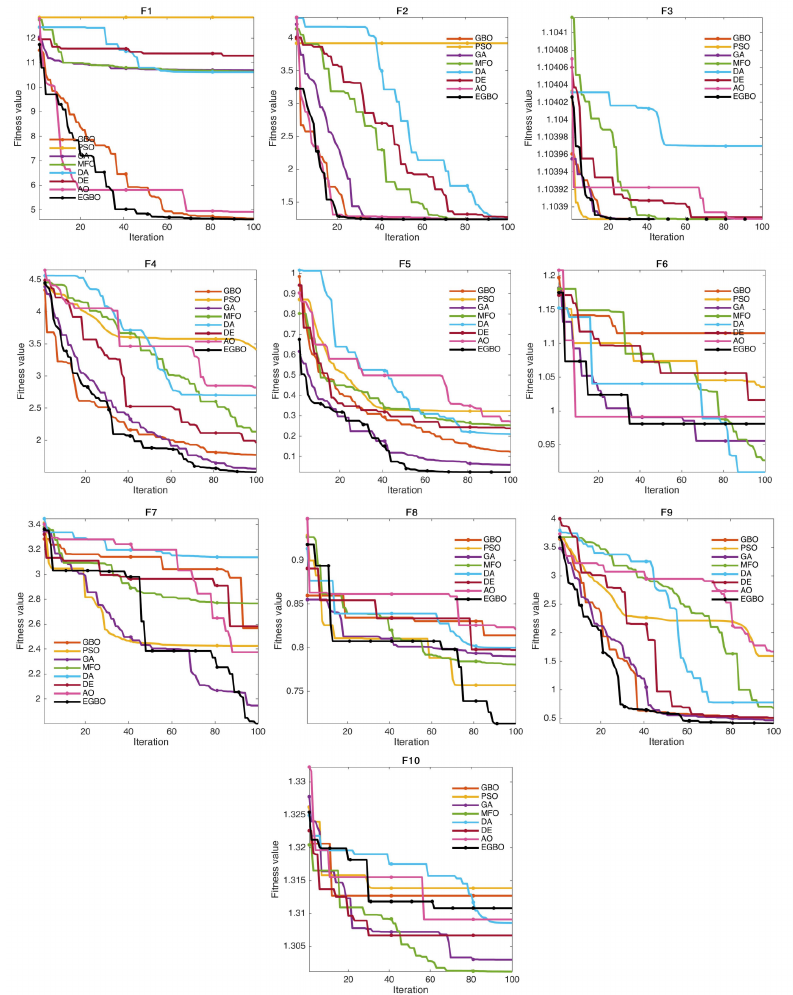
Figure 3. Convergence curves for the proposed EGBO and the compared